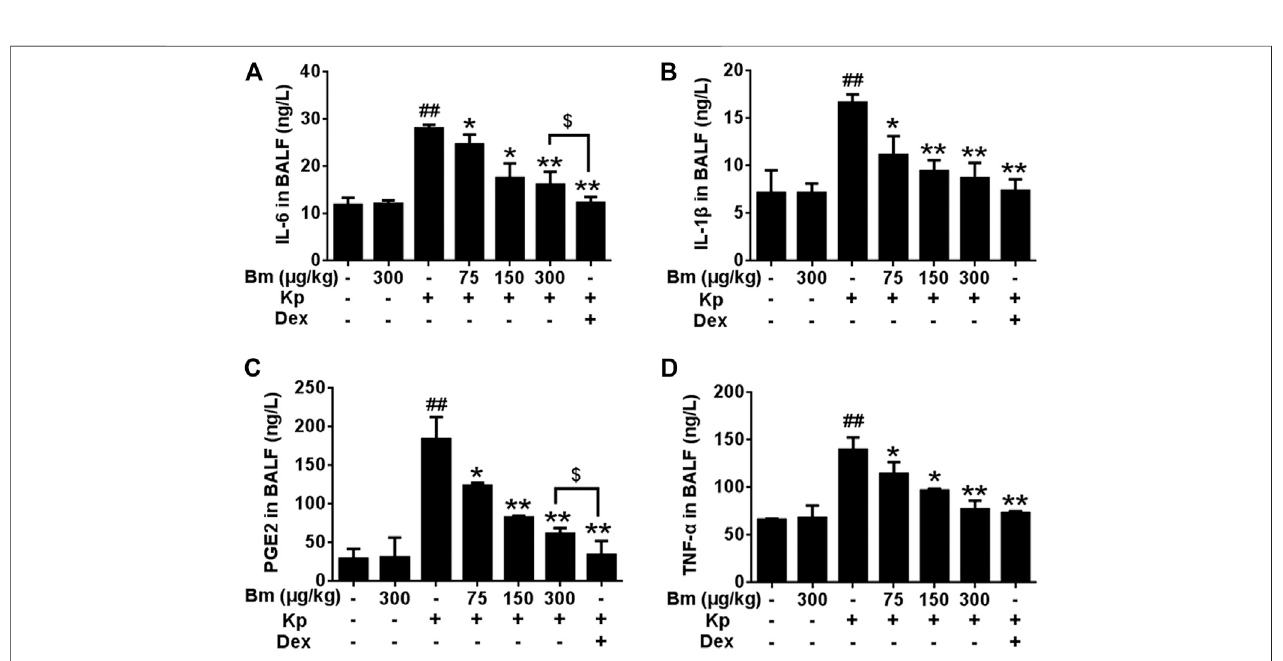
FIGURE3| Effectsof Bergeninmonohydrate onIL-1 β (A) ,IL-6 (B) ,PEG2 (C) andTNF- α (D) productionandsecretioninBALFfrom Klebsiellapneumonia -induced pneumonia mice. All data are presented as the means ± SEM ( n (cid:2) 5). ## p < 0.01 vs the Control group; * p < 0.05 and ** p < 0.01 vs the Klebsiella pneumonia group; $ p < 0.05 vs the Dex